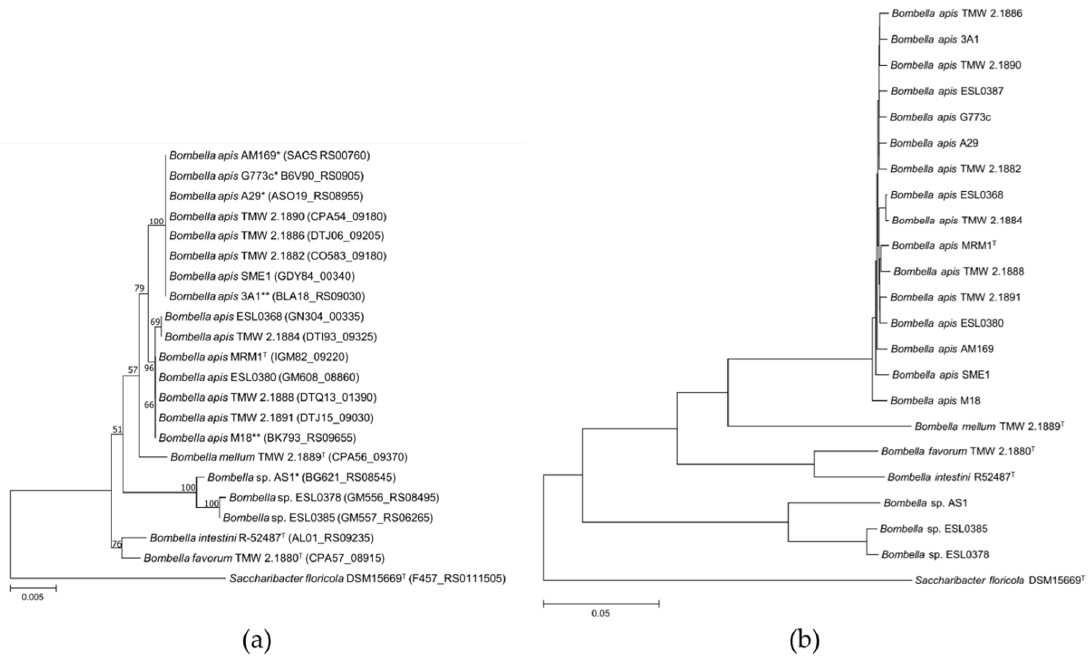
Figure 1. ( a ) Neighbor-joining (NJ) tree based on partial 16S rRNA gene sequences and ( b ) phylo- genetic tree based on ANI-values via ANIb algorithm as implemented in JSpeciesWS. Saccharibacter